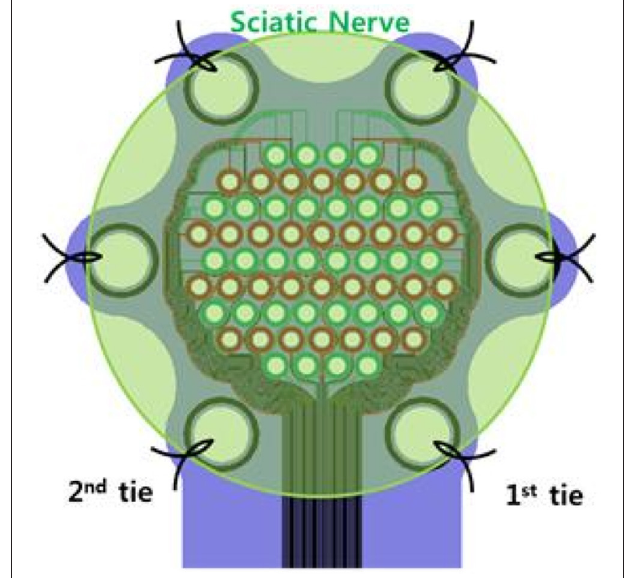
FIGURE 6 | Flat sieve electrode. Reproduced with permission from Jeong et al.